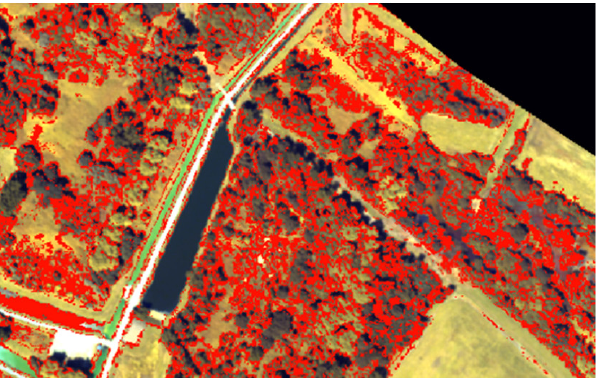
Figure 7. Average F1-scores obtained with reflectance spectra, first derivation, and continuum re- moval.